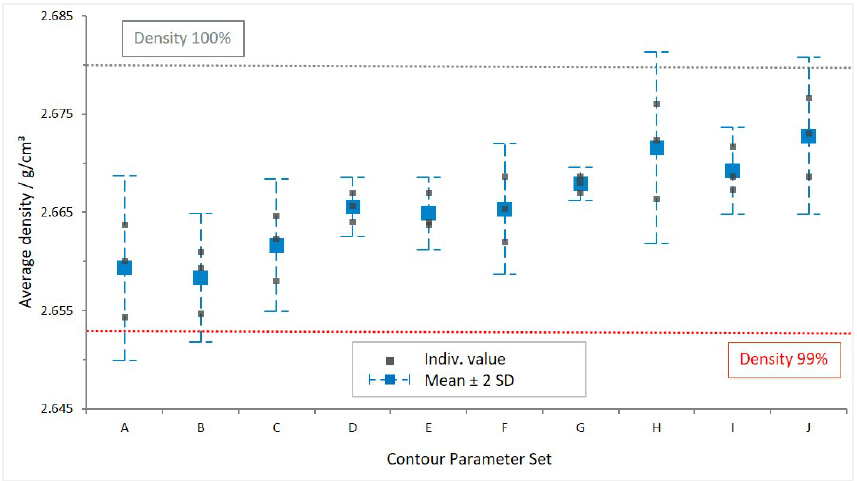
Figure 6. Density per manufacturing parameter set, mean ± 2SD; reference density: 100% = 2.68 g/cm 3